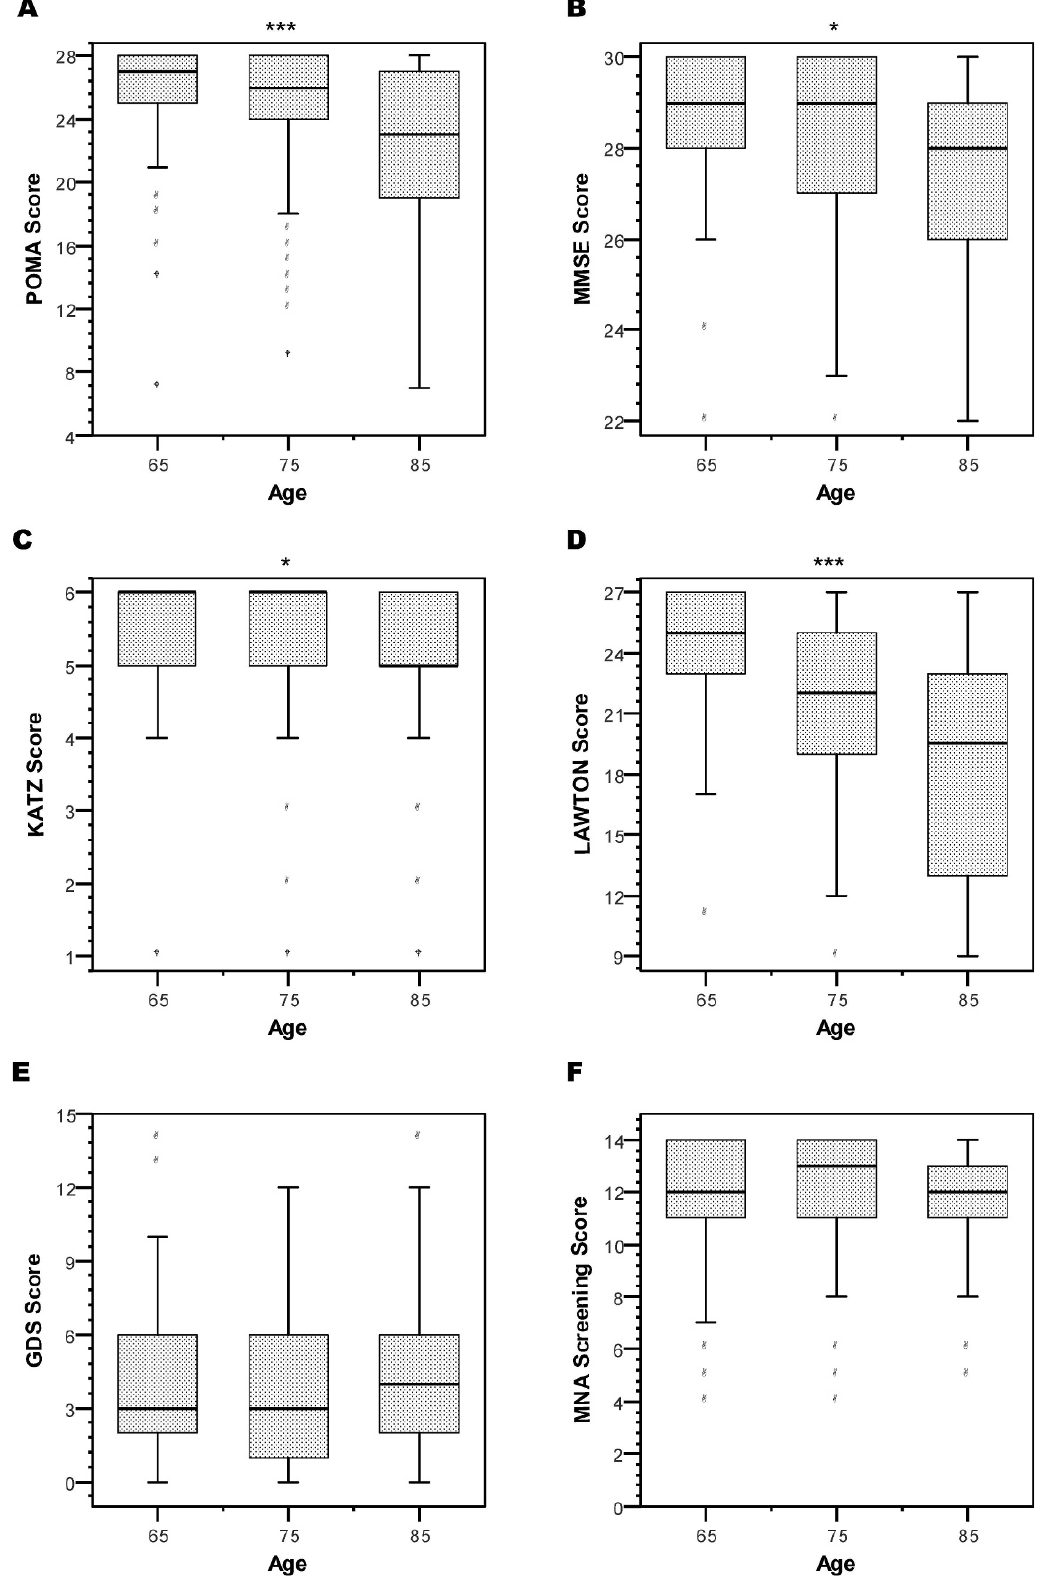
Figure 2 - Graphs depicting the effects of age on the POMA (A), MMSE (B), Katz (C), Lawton (D), GDS (E) and MNA (F) scores. Note that performance declined as a function of increasing age when the POMA, MMSE, Katz and Lawton assessment instruments are used. 65: from 65 to 74 years old; 75: 75 to 84 years old; 85: from 85 to 95 years old; * p , 0.05; *** p ,